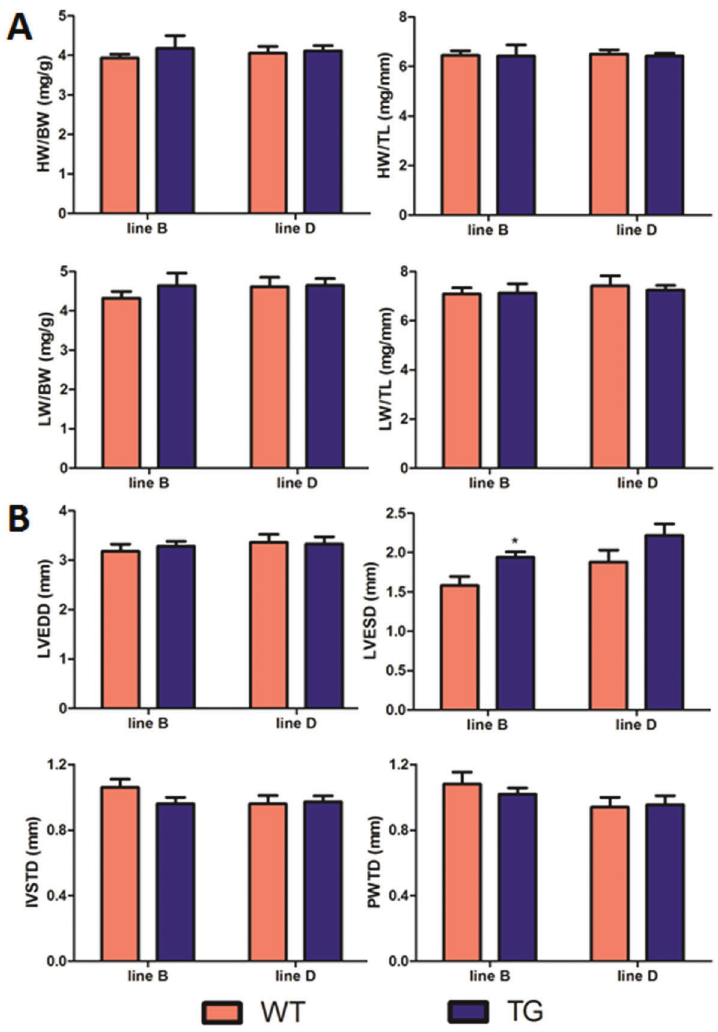
Figure 3. MyD88 transgenic (TG) mice did not show an increased heart size. Data are reported as means ± SE. A , Relative heart weights (HW/ BW and HW/TL) of wild-type (WT) and TG mice at 5 months of age. HW: heart weight (mg); BW: body weight (g); TL: tibia length (mm); LW: liver weight (g) (n=3 – 6). The heart and liver were removed, weighed, and normalized to body weight or tibia length. B , Echocardiographic analysis of WT and TG hearts at 5 months of age (n=5 – 11). LVEDD: left ventricular end-diastolic dimension; LVESD: left ventricular end-systolic dimension; IVSTD: interventricular septal thick- ness in diastole; PWTD: posterior wall thickness in diastole; *P o 0.05 (two-tailed Student ’ s t